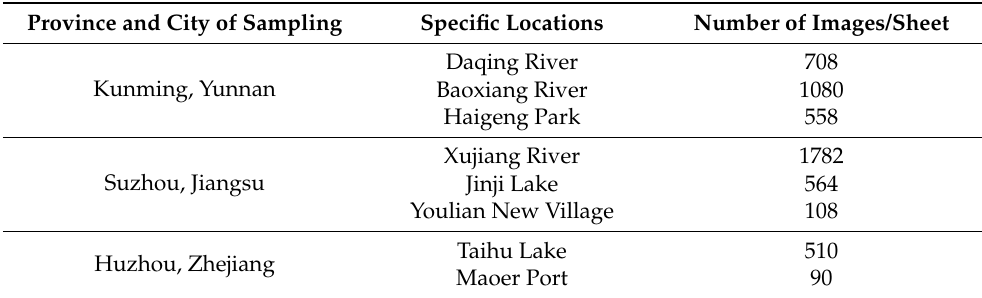
Table 1. Distribution of cyanobacterial blooms